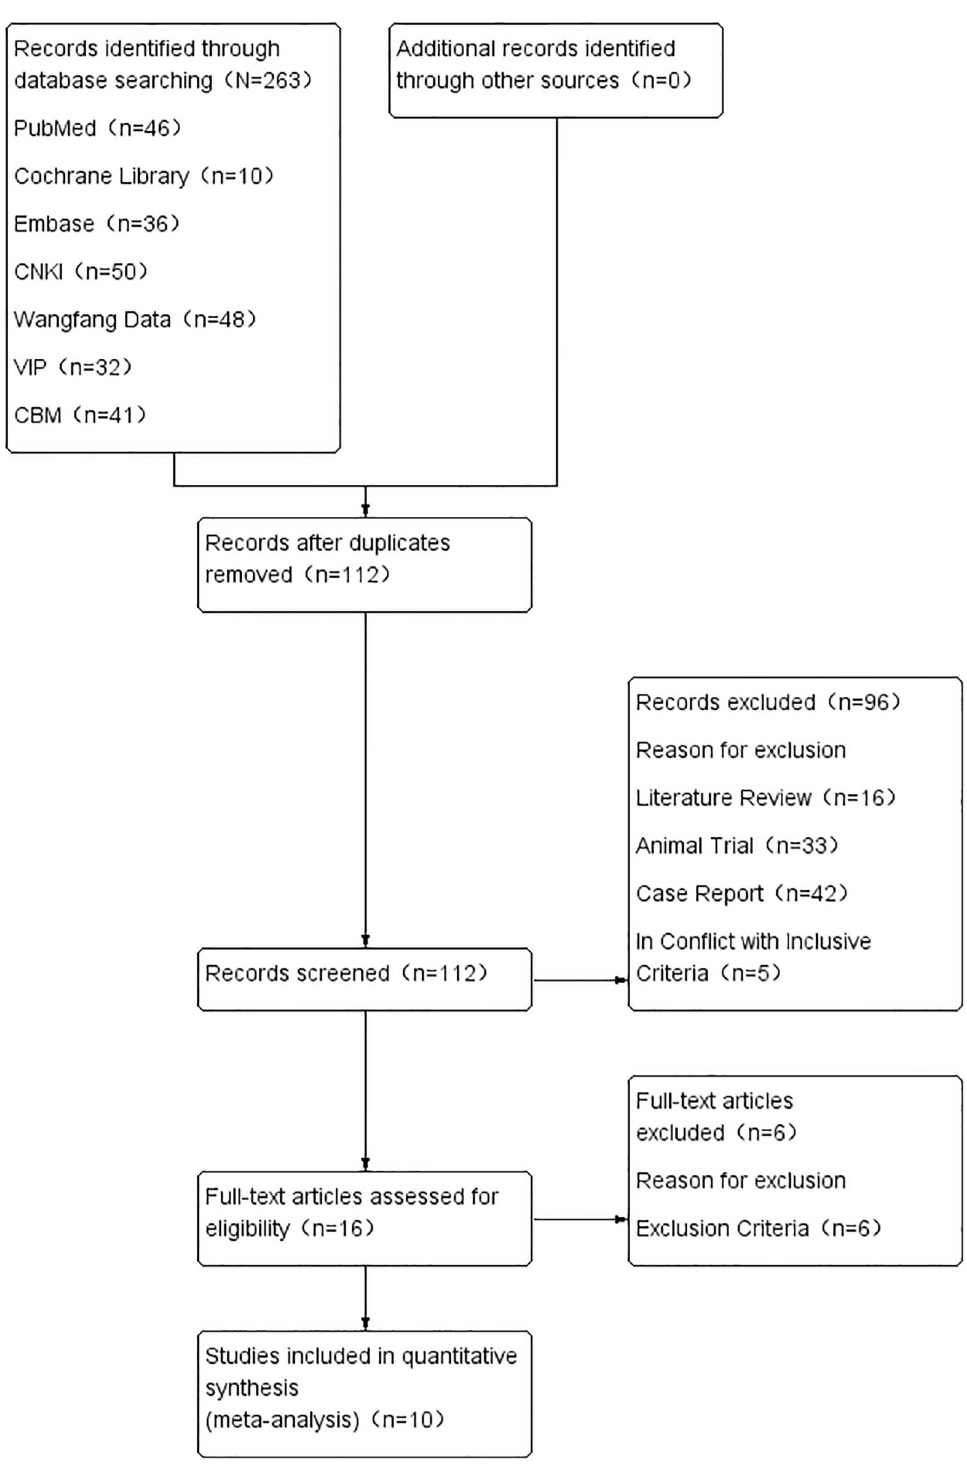
Fig 1. Flow chart of literature retrieval and trial selection.